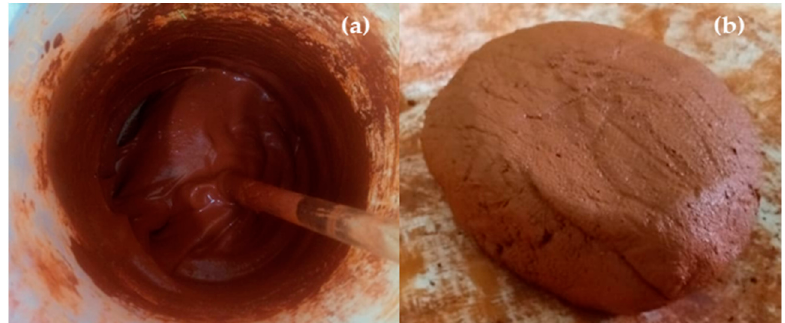
Figure 5. Processing of pre-treated red mud fine powders with 1.0 M HCl solution. Red mud fine powders mixed with 1.0 M HCl solution ( a ); and red mud pasty cake ( b ).